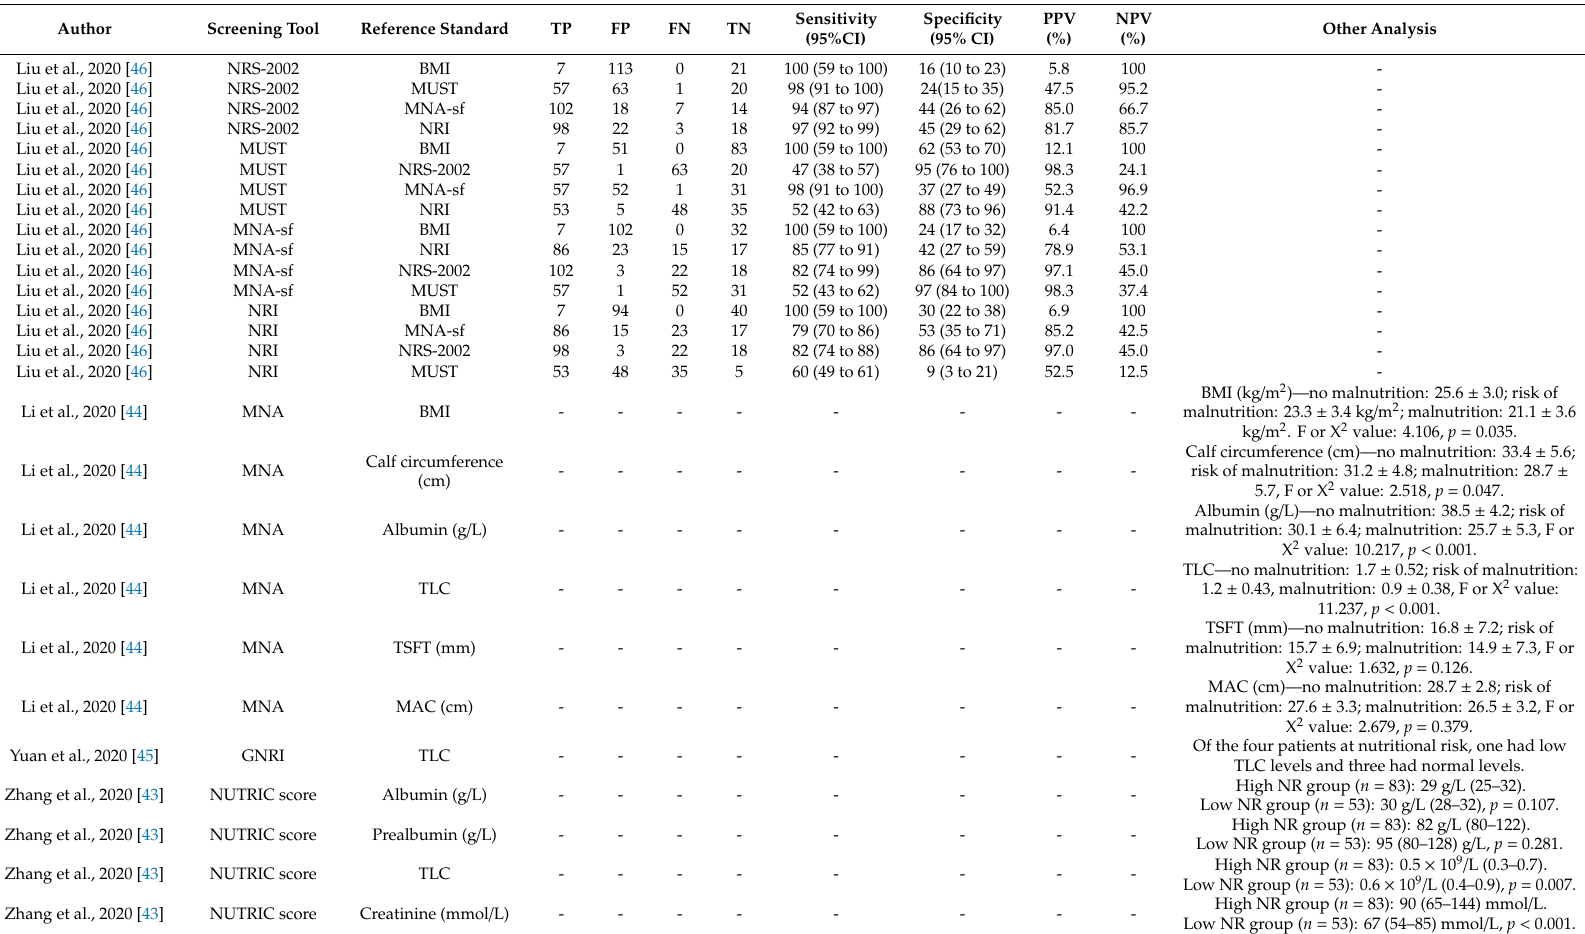
Table 5. Diagnostic performance of Nutritional Screening Tools identifying older adults with COVID-19 at nutritional risk or with malnutrition.